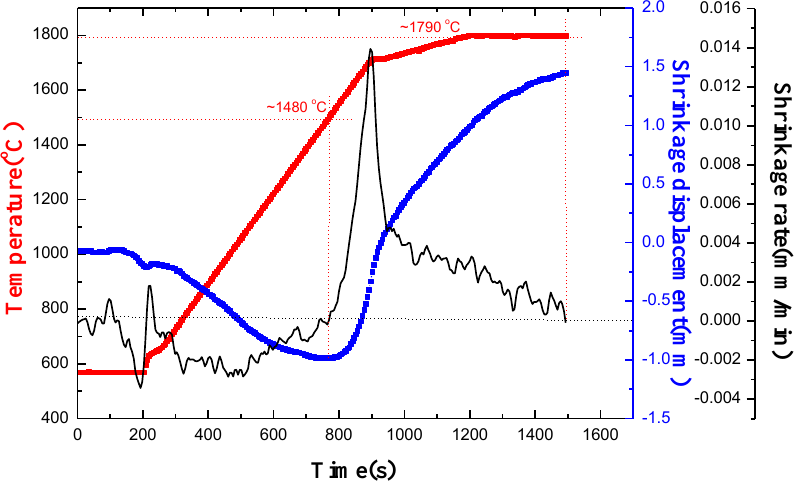
Figure 1. Densification curves for pure TiB 2 powders sintered at 1800 °C and held for 5 min under 50